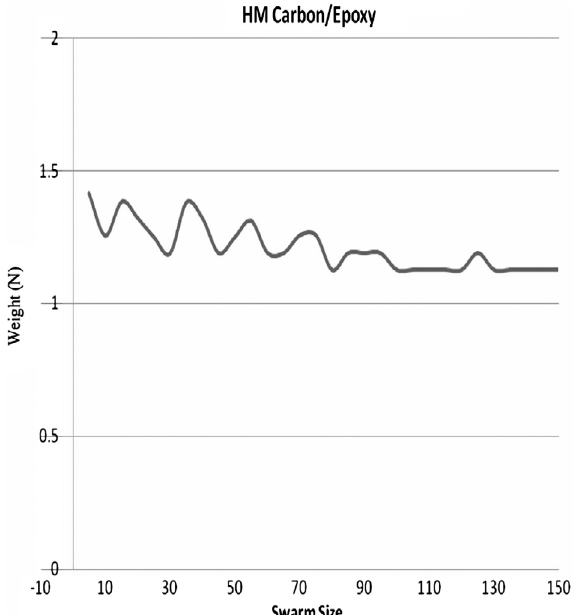
Figure 7. Variations of weight of HM Carbon/Epoxy drive shafts with swarm size.